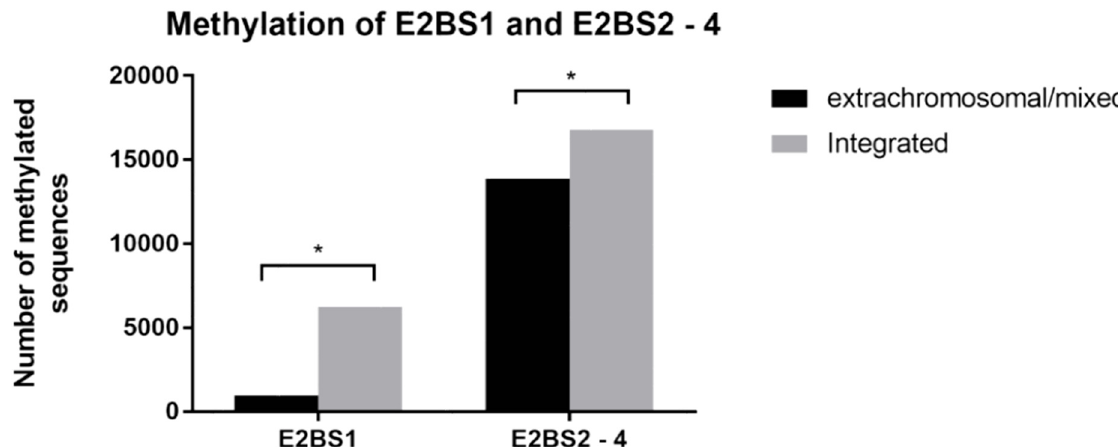
Figure 2. CpG methylation levels of activating E2BS1 and repressive E2BS2-4. Numbers of methylated sequences were compared between samples with extrachromosomal/mixed or integrated viral genomes both for activating E2BS1 and repressive E2BS2-4. The difference was statistically significant for both areas ( p = 0.028 for E2BS1 and p = 0.034 for E2BS2-4).